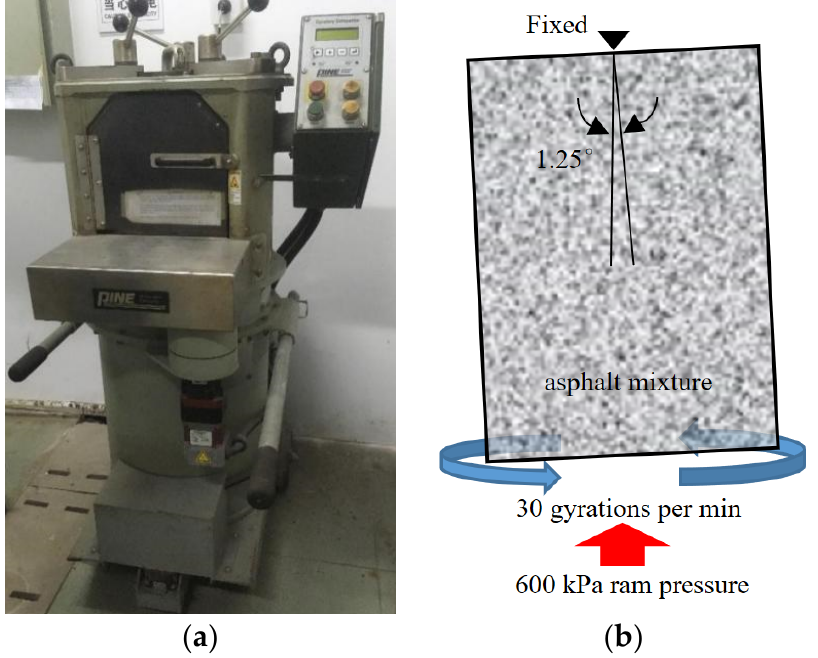
Figure 3. Superpave gyratory compactor: ( a ) the compactor; ( b ) the compaction process.